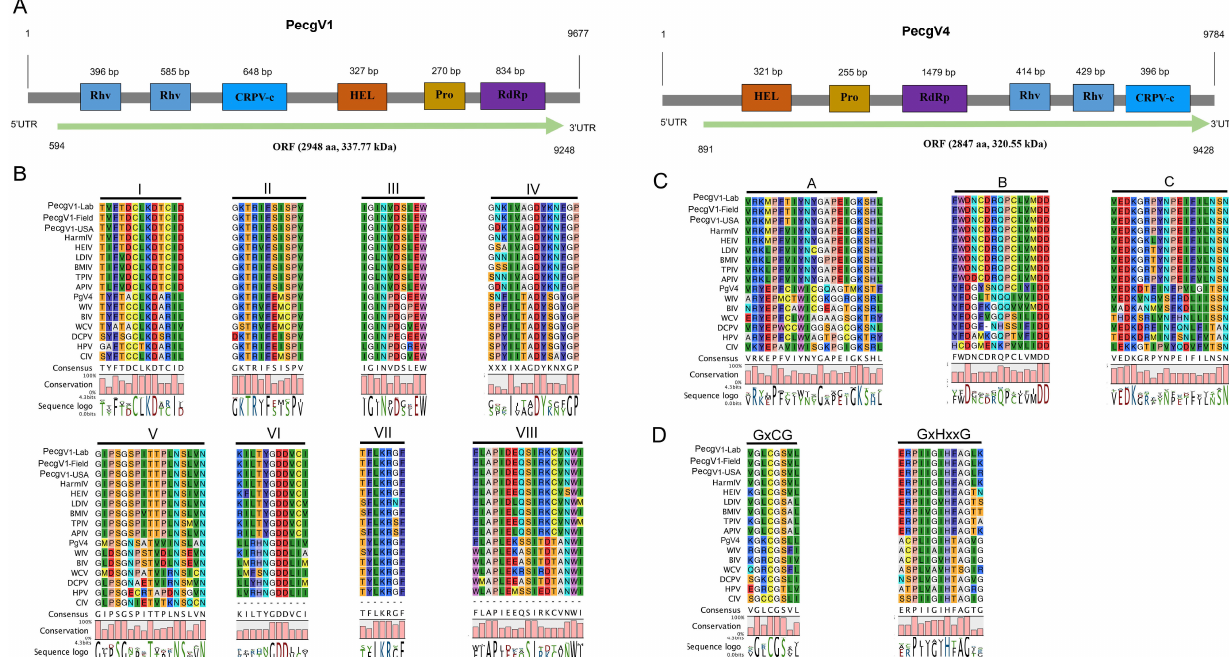
Figure 1. Genome organization and amino acid alignment of PecgV1 and PecgV4. ( A ): CDD and InterProScan analysis of genome structure of PecgV1 and PecgV4. Rhv: Picornavirus capsid protein domain_like; CRPV_c: CRPV capsid protein like; Hel: RNA helicase; Pro: protease; RdRp: RNA-dependent RNA polymerase; UTR: untranslated region; ORF: open reading frame. ( B ): RdRp amino acid alignment. ( C ): Helicase amino acid alignment. ( D ): Protease amino acid